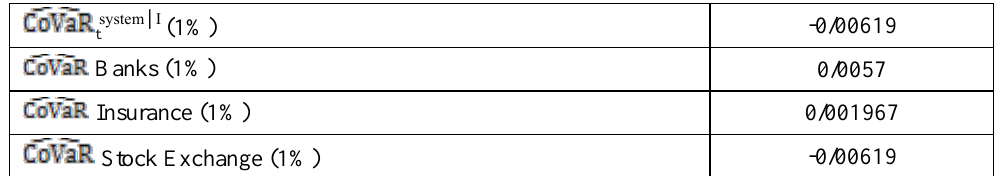
Table 6. CoVaR System, Bank, Insurance and Exchange (with 1% Quantil